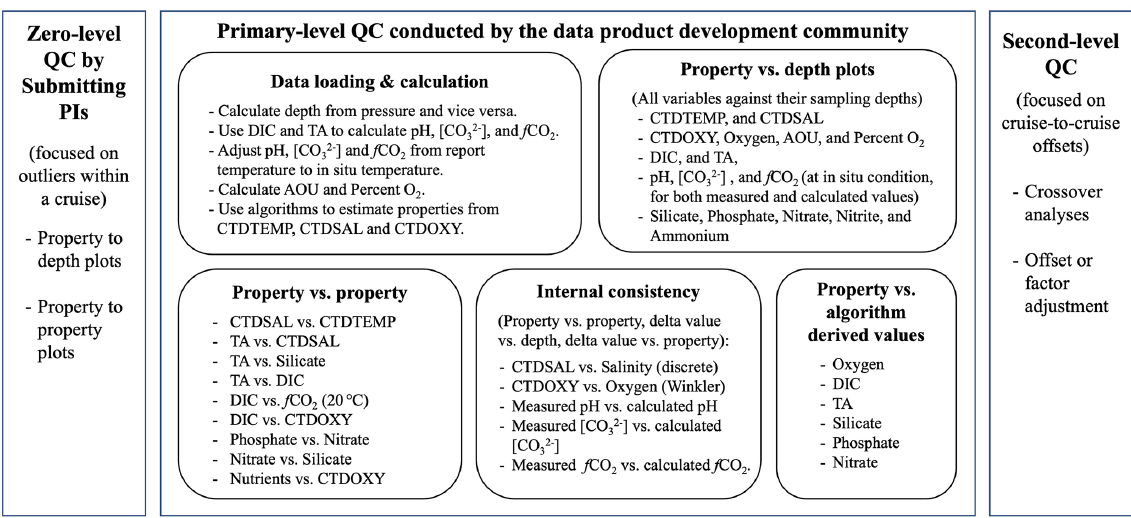
Figure 2. A diagram showing major steps of the quality control (QC) process. Note uncertainty is separated into outliers (scatter) and systematic offset (all data from the cruise has a bias). [CO 2 − ] is carbonate ion content; f CO 2 is fugacity of carbon dioxide. Refer to Table 1 3 for the rest of the